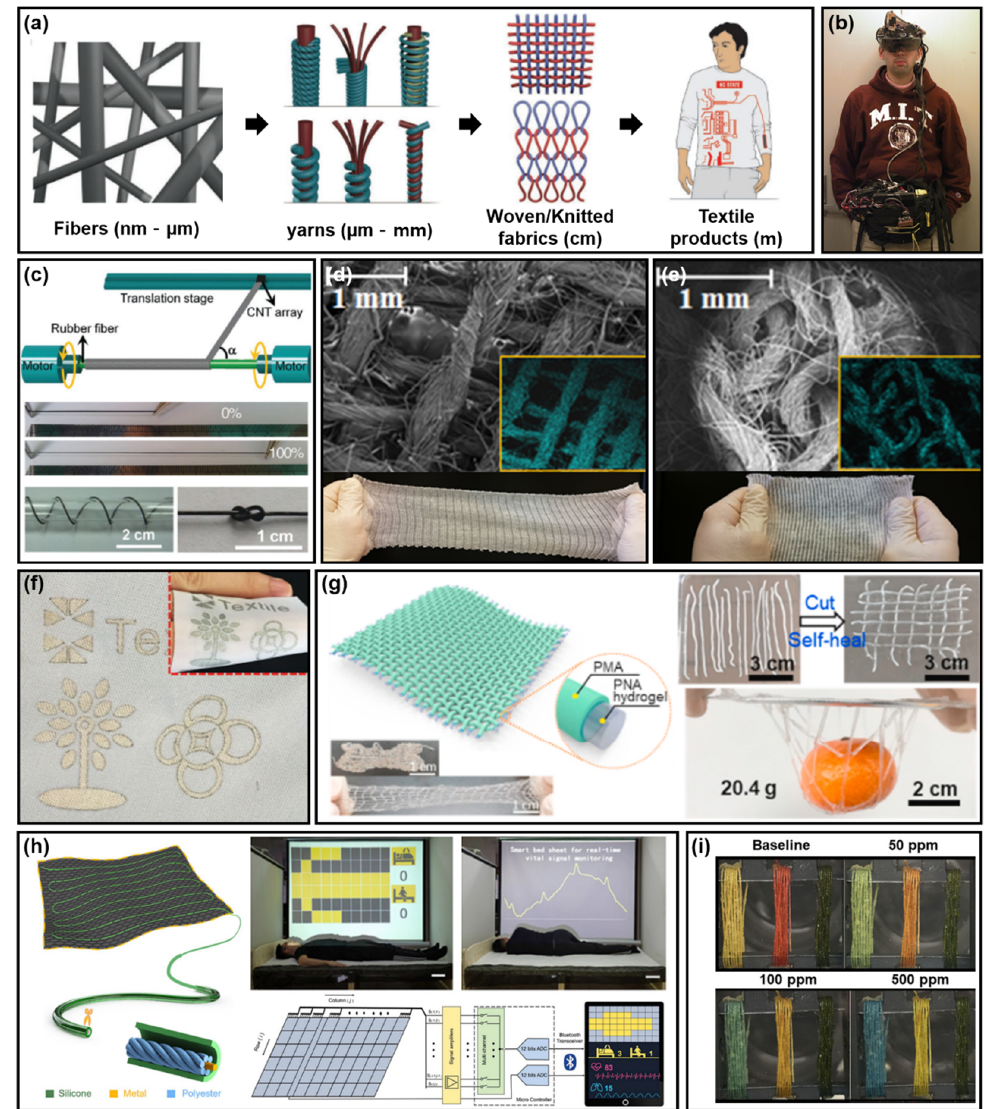
Figure 7. ( a ) Hierarchical structures of textiles at four levels of scale [252], ( b )in the 1980s, first produced conductive textiles by attaching various type of electronic devices to clothes in the lab of MIT [253]. ( c ) Conductive textile manufactured by winding CNT on a rubber fiber using a motor, durable to various deformations. SEM image of Lyocell–based [255], ( d ) weave, and ( e ) knit coated with a mixture of PEDOT and PPy [256]. ( f ) Textile fabric with pattern deposited using a laser scribing method and electroless plating [257]. ( g ) TENG textile woven with PNA/PMA core sheath fiber and stretching deformation of TENG textile ( left ), photo of the cut PNA hydrogel fiber restored by self–healing and lifting 20.4 g of mandarin oranges using it ( right ) [258]. ( h ) Schematic of a washable functional fiber composed of silicone/metal/polyester ( left ), and figure showing the possibility of real–time sleep monitoring ( right ) [259]. ( i ) Washable gas sensing smart textile showing color change according to ammonia concentration [260].